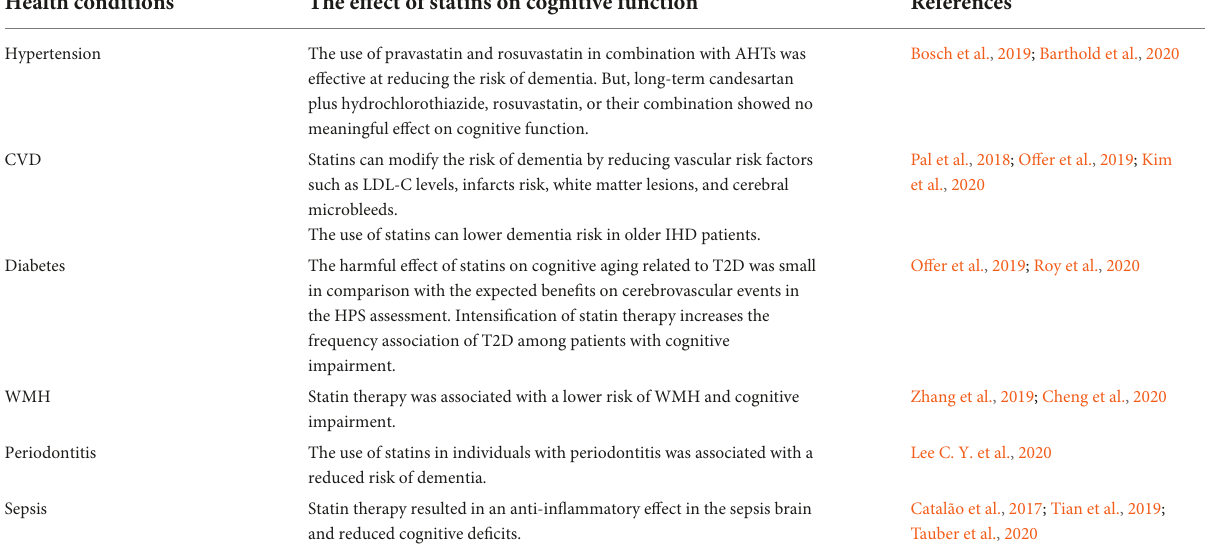
TABLE 1 Different health conditions of patients and their impacts on the statins’ cognitive